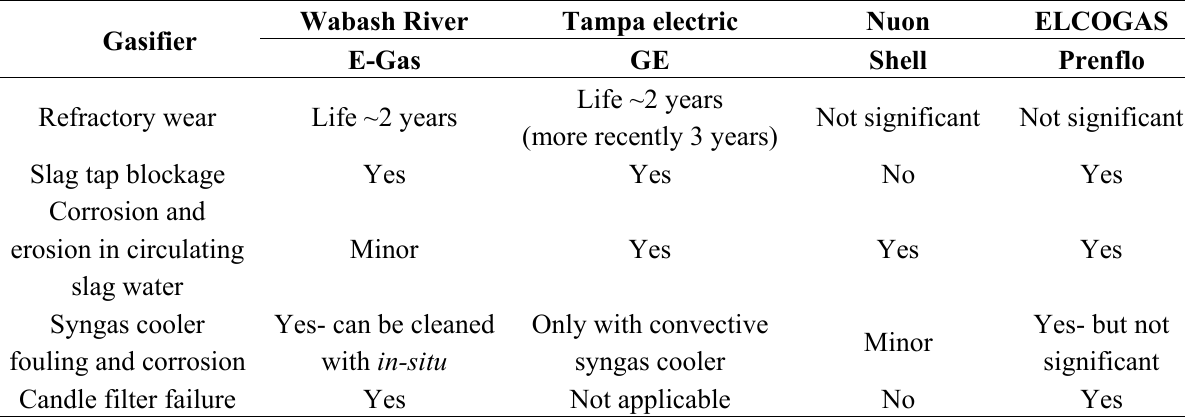
Table 4. Mineral matter realted outages in major coal-based IGCC power plants (Adapted from Holt